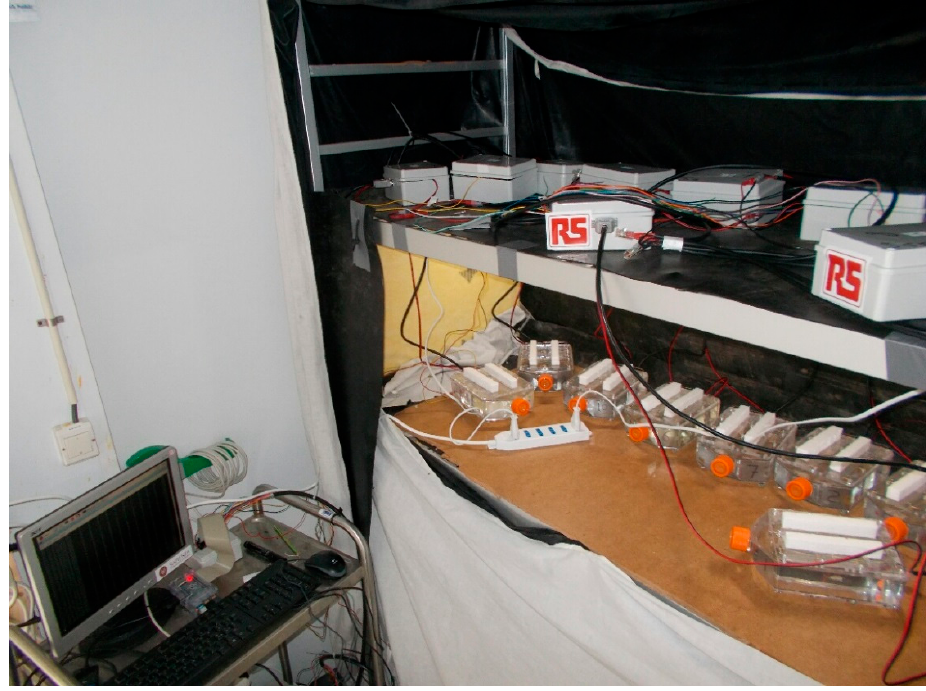
Figure 14. The complete set-up inside the cold room.